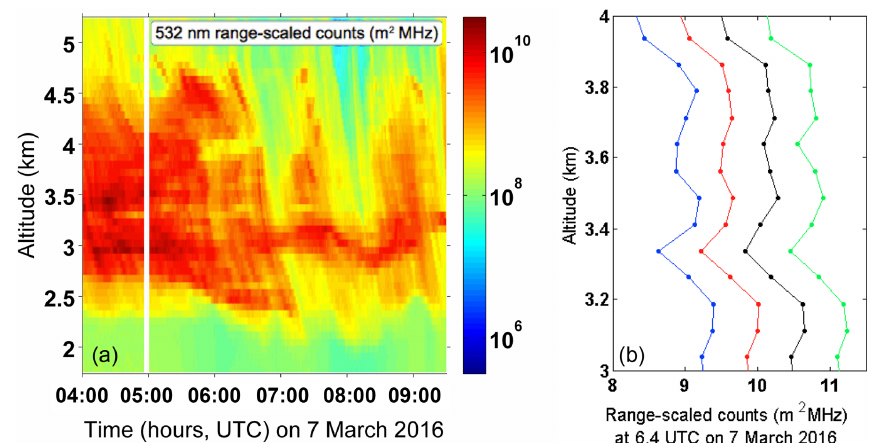
Figure 3. The same measurements as Figs. 1 and 2, with altitude bins 10 times as large, are shown in panels (a) and (b) , respectively. Resolutions are 1min × 75m. The fine ( < 10m) laminations are no longer discernible. Only the much larger features (e.g. between 3.2 and 3.4km)